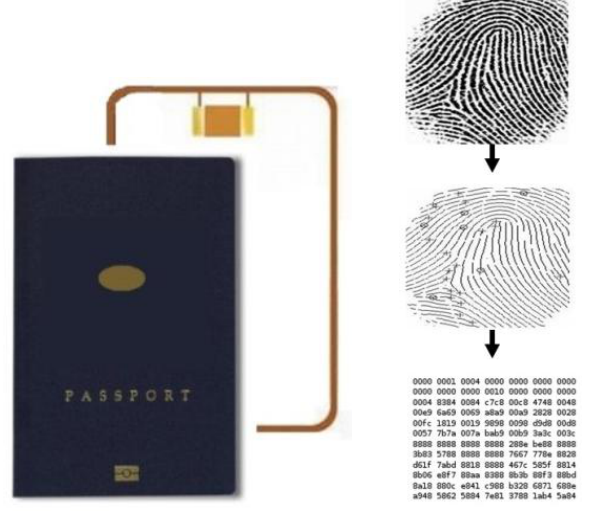
FIGURE 4. The new EU e-Passport includes a fingerprint